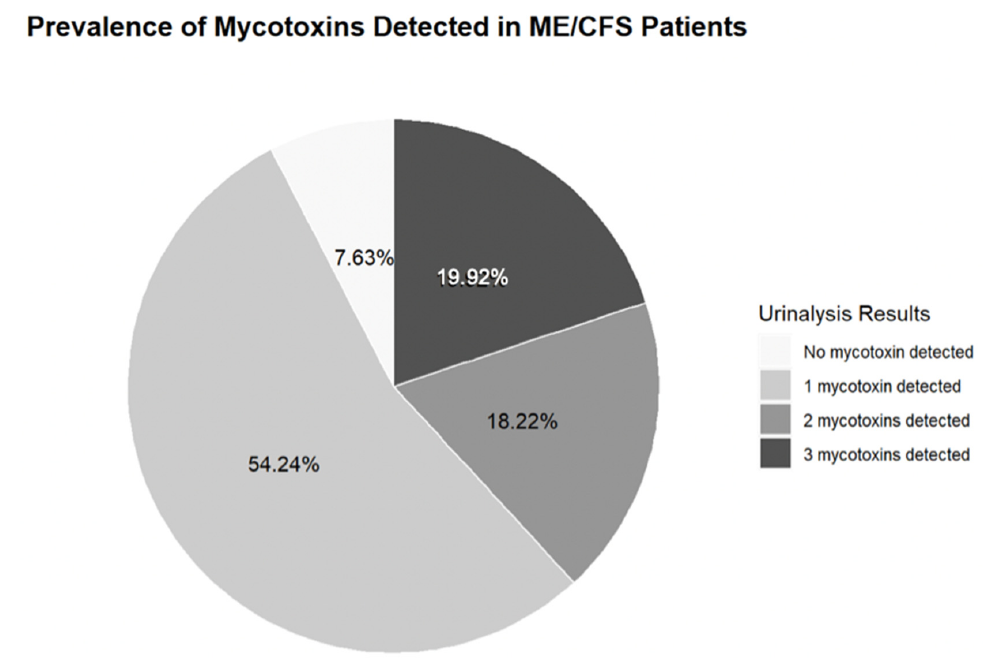
Figure 1. Among ME/CFS patients (N = 236) with a chronic exposure history to mold, the percentage of patients who did not test positive for mycotoxins at all was 7.63%. The proportion of those who tested positive for only one mycotoxin, regardless of type, was 54.24%. Percentage of patients who tested positive for all three types of mycotoxins was 19.92 percent. The overall prevalence of mycotoxins in the urinalysis was 92.4 percent. Table 1. Number of ME/CFS patients who tested positive for mycotoxins in urinalysis by gender and age.